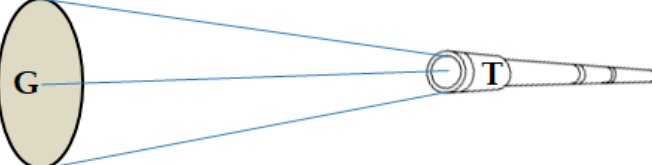
Figure 3. Formation of an image of the galaxy on a photographic plate of the telescope located in an arbitrary place on the celestial sphere. G—Galaxy; T—Telescope of an observer.